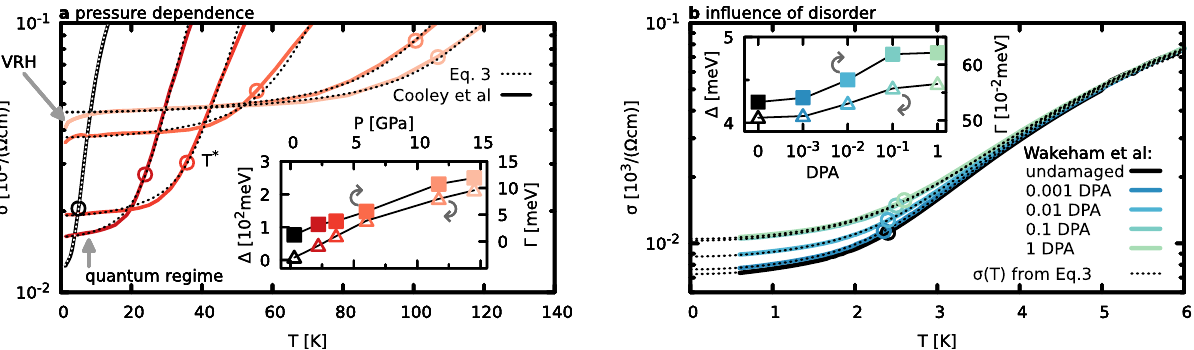
Fig. 5 Analysis of the quantum regime in Ce 3 Bi 4 Pt 3 . We fi t the conductivity σ ( T ) = 1/ ρ ( T ) from a Cooley et al. 5 (colored lines correspond to pressures indicated in the inset) and b Wakeham et al. 6 (colored lines indicate the degree of disorder quanti fi ed in displacements per atom (DPA)) with the phenomenological quantum conductivity Eq. (3) (dashed lines). The agreement is excellent: from a fi nite residual value for T → 0, the conductivity grows algebraically (see the quantum regime formula: Eq. (4)) up to the crossover temperature T * (circles). Above, higher powers in T become relevant as σ ( T ) enters the exponential (semi-classical) regime. For pressures P > 4 GPa and very low T , the experimental conductivity deviates from the quantum regime Þ 1 = 4 (cid:3) 5 . The fi t parameters Δ and Γ are given in the insets. and instead matches 3D variable-range hopping (VRH) characteristics, / exp ½ð T = T 0